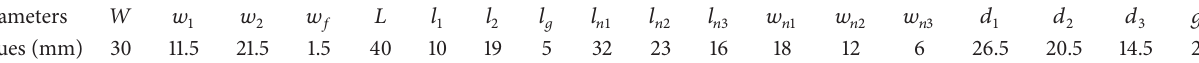
Table 1: Optimized geometrical parameters of the proposed multiband antenna.